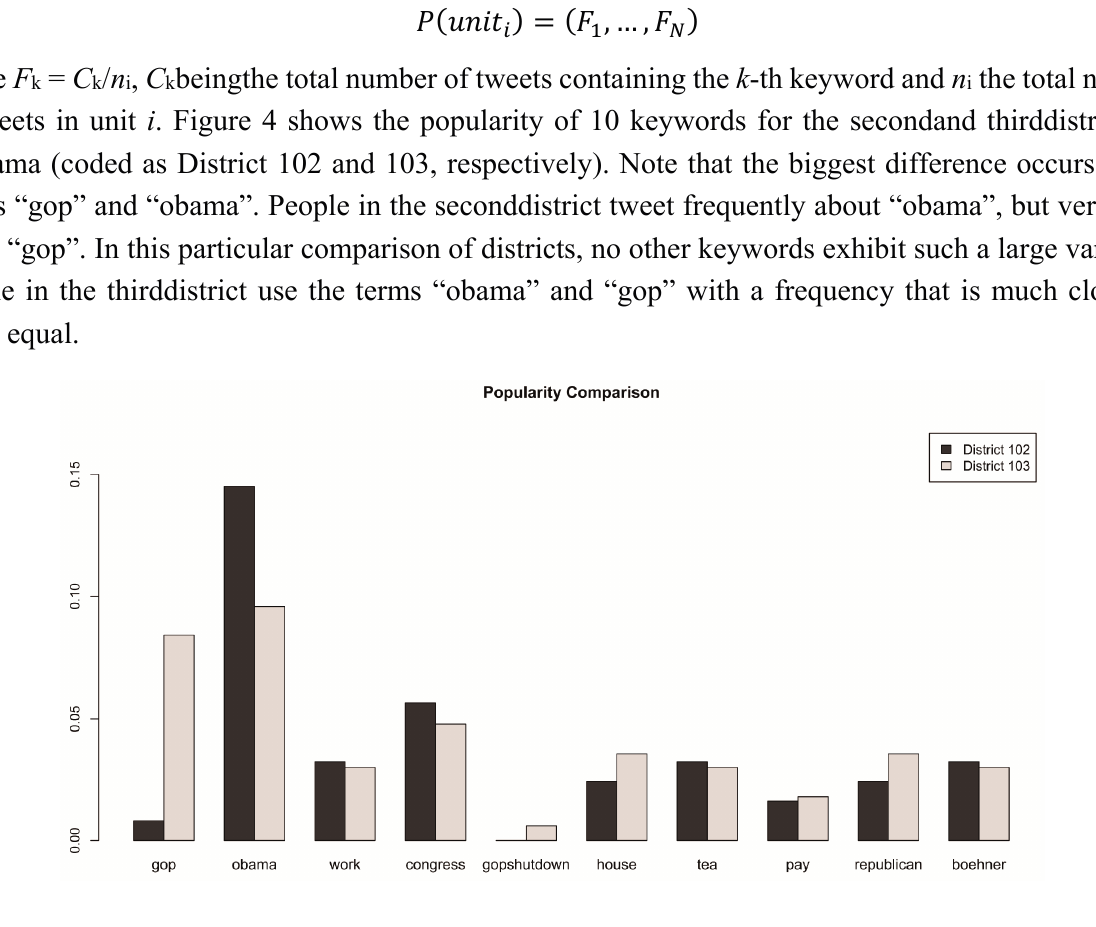
Figure 4. Keyword popularity between the secondand thirddistricts of Alabama (coded as District 102 and District 103, respectively). Table 1. Ten most frequent terms in the Twitter